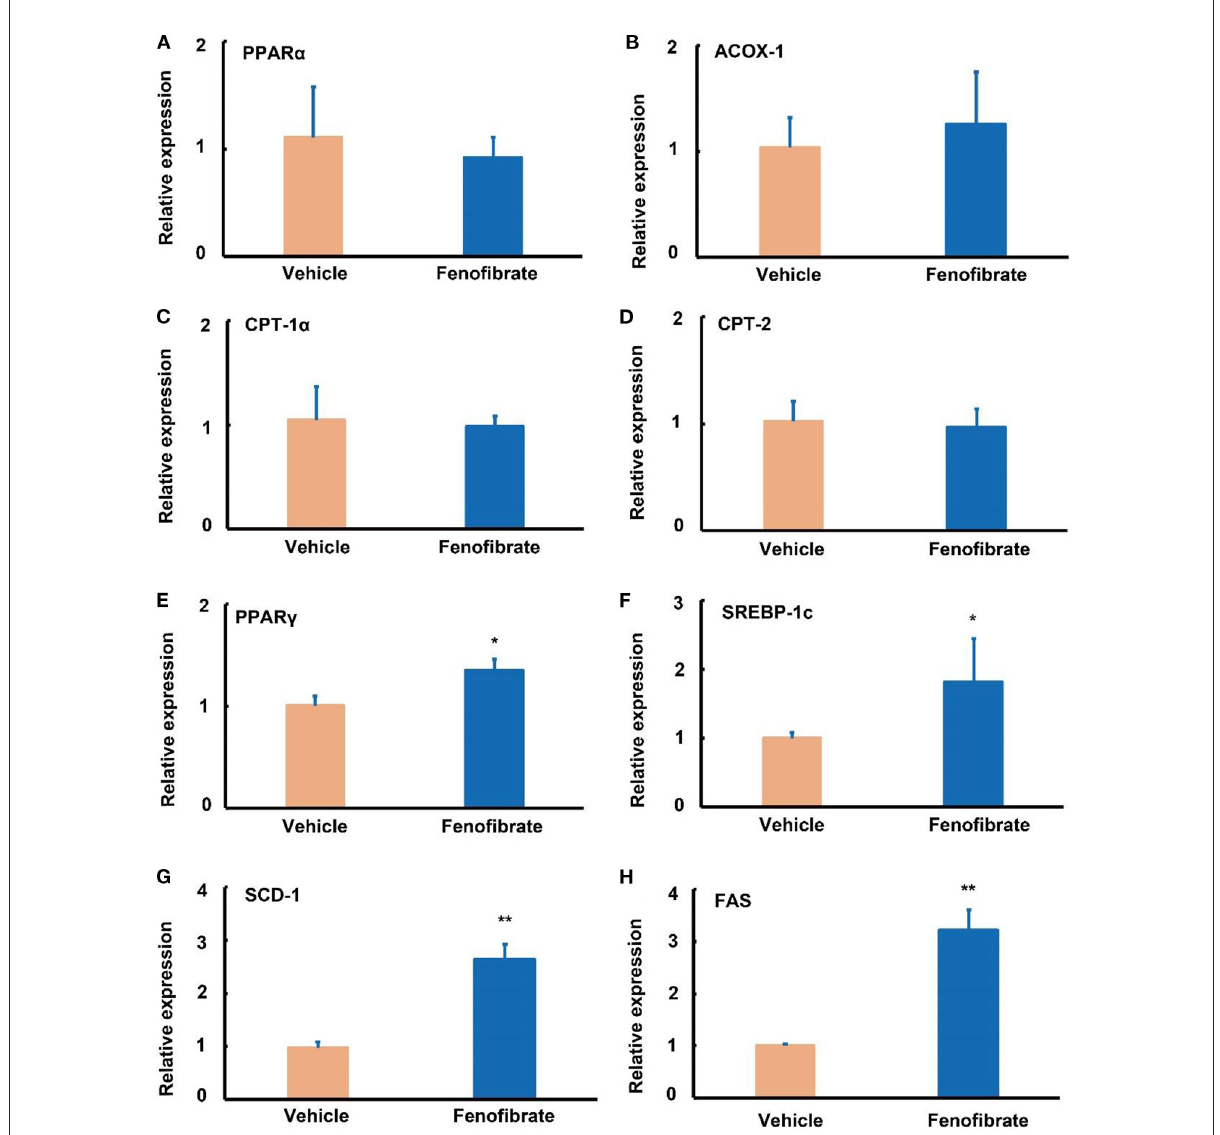
FIGURE4 Effect of fenofibrate on the expression of genes involved in lipid metabolism in the liver of the ob/ob mice. Gene relative expression of (A) peroxisome proliferator activated receptor (PPAR) α ( n = 12); (B) acyl-CoA oxidase (ACOX)-1 ( n = 12); (C) carnitine palmitoyltransferase (CPT)-1 α ( n = 12); (D) CPT-2 ( n = 12); (E) PPAR γ ( n = 7); (F) sterol regulatory element binding protein (SREBP) − 1c ( n = 9); (G) stearoyl Coenzyme A desaturase-1 (SCD-1) ( n = 4); (H) fatty acid synthase (FAS) ( n = 4). The RT-qPCR experiment was repeated for one more time to confirm the gene expression trends of PPAR α , ACOX-1, CPT-1 α , CPT-2, and SREBP-1c. Data were expressed as mean ± SD, and the statistical analysis was performed by Student- t -test. * means significantly different at p < 0.05 vs. Vehicle group; ** means significantly different at p < 0.01 vs. Vehicle group. Vehicle: mice were treated with 0.5mL of water by gavage for 13 weeks; Fenofibrate: mice were treated with 0.5mL of fenofibrate suspension liquid at the dose of 20 mg/kg/d by gavage for 13 weeks.